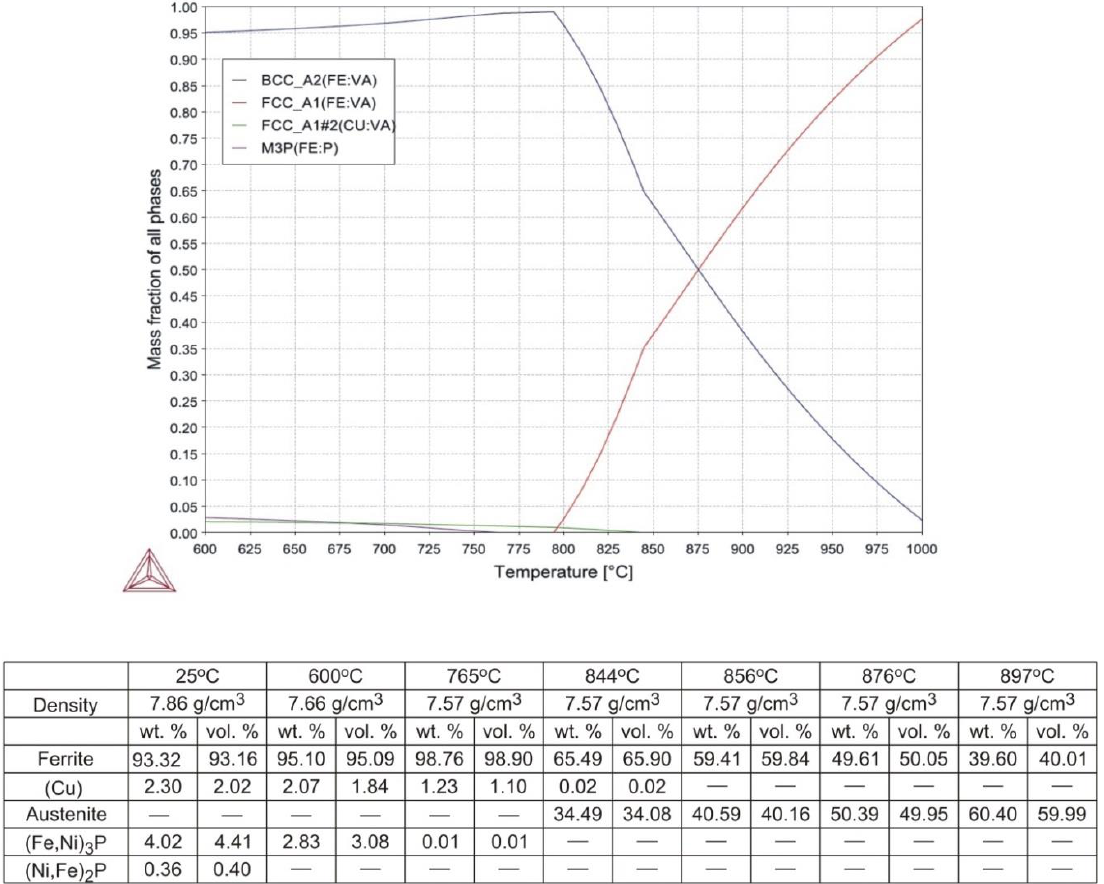
Figure 2. Effect of temperature on phase composition of the newly designed Fe-2.3% Cu-1% Ni-0.7% P alloy.